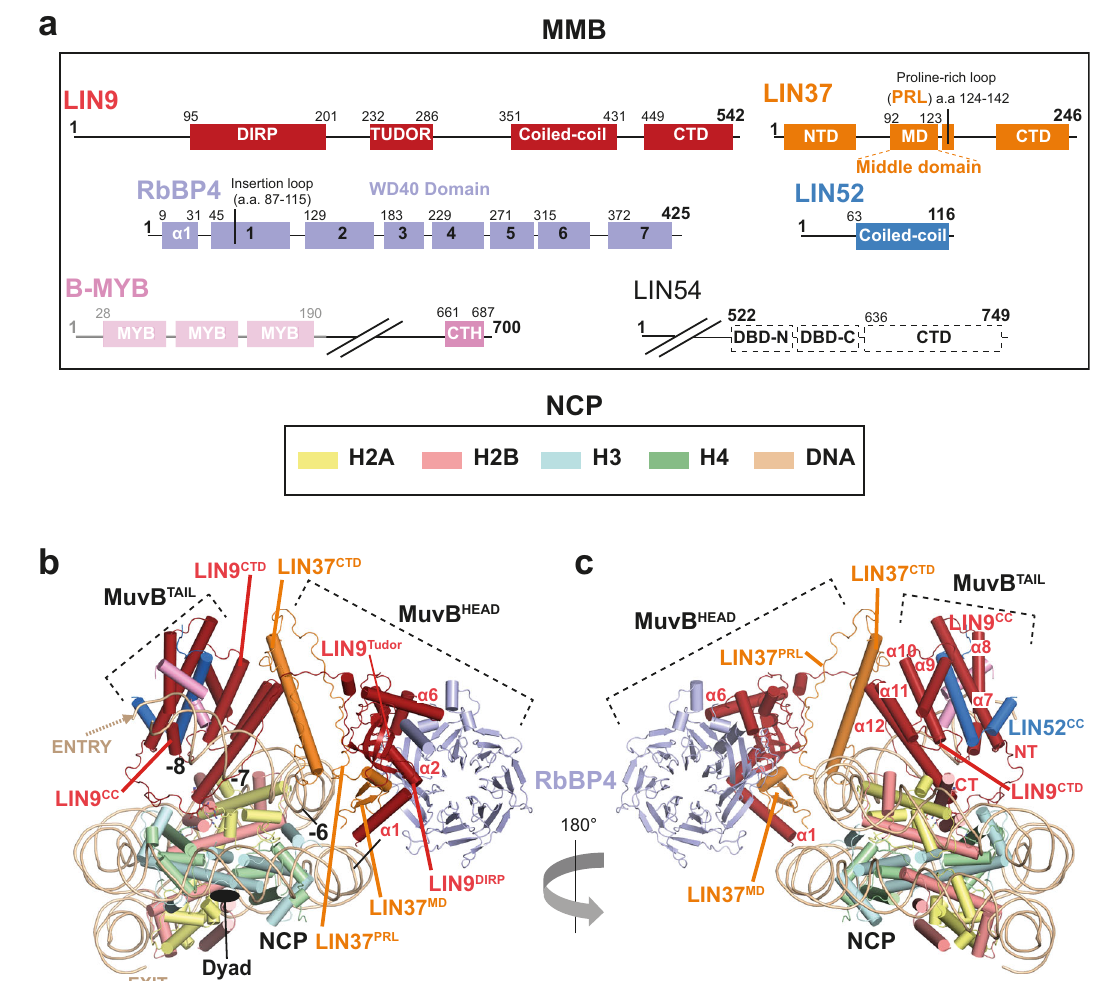
Fig.1|StructureoftheMMBcomplexwiththenucleosomecoreparticle(NCP), overall complex assembly, and binding mode. a Schematics showing domains and functional regions on the subunits of the MMB complex represented in linear form. B-MYB N-terminus containing a DNA binding domain is disordered in the cryo-EM structure and it is represented with fading colours. LIN54 is represented with dashed lines for clarifying that this protein was not included in the core MMB